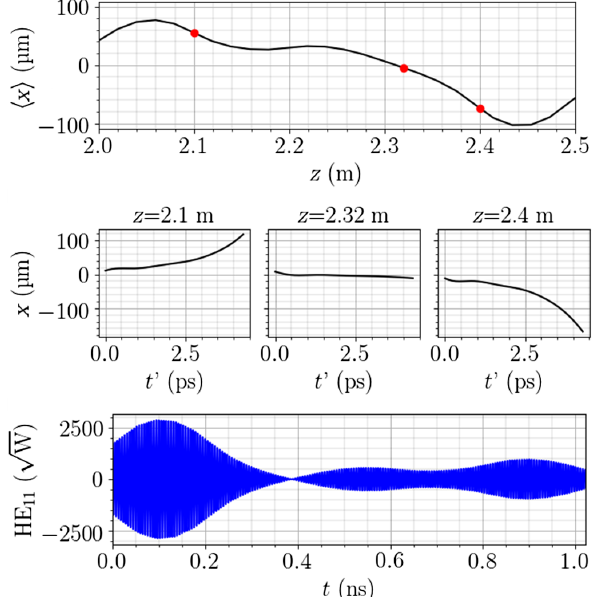
FIG. 17. Bunch trajectory through the fifth 0.5-m long CWG module in the CWA showing the center of charge of the electron bunch (top panel), the bunch curvature at three locations in the CWG (middle panel), and the 190-GHz HE 11 mode at the end of the CWG